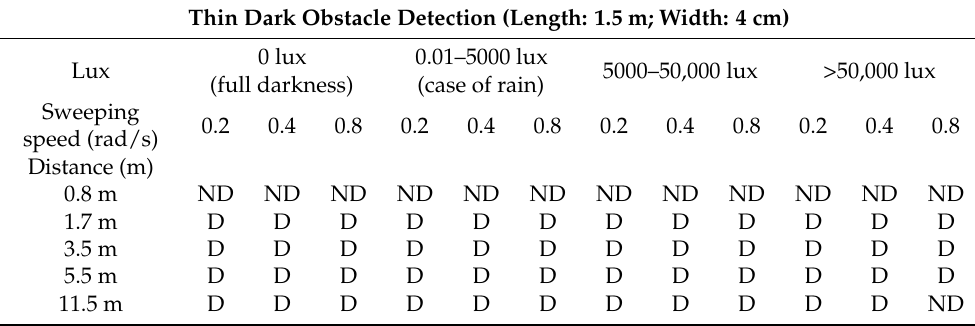
Table 2. This table shows the results of detection for a thin dark obstacle at different distances, sweeping speeds and illuminations (D means detected, and ND means not